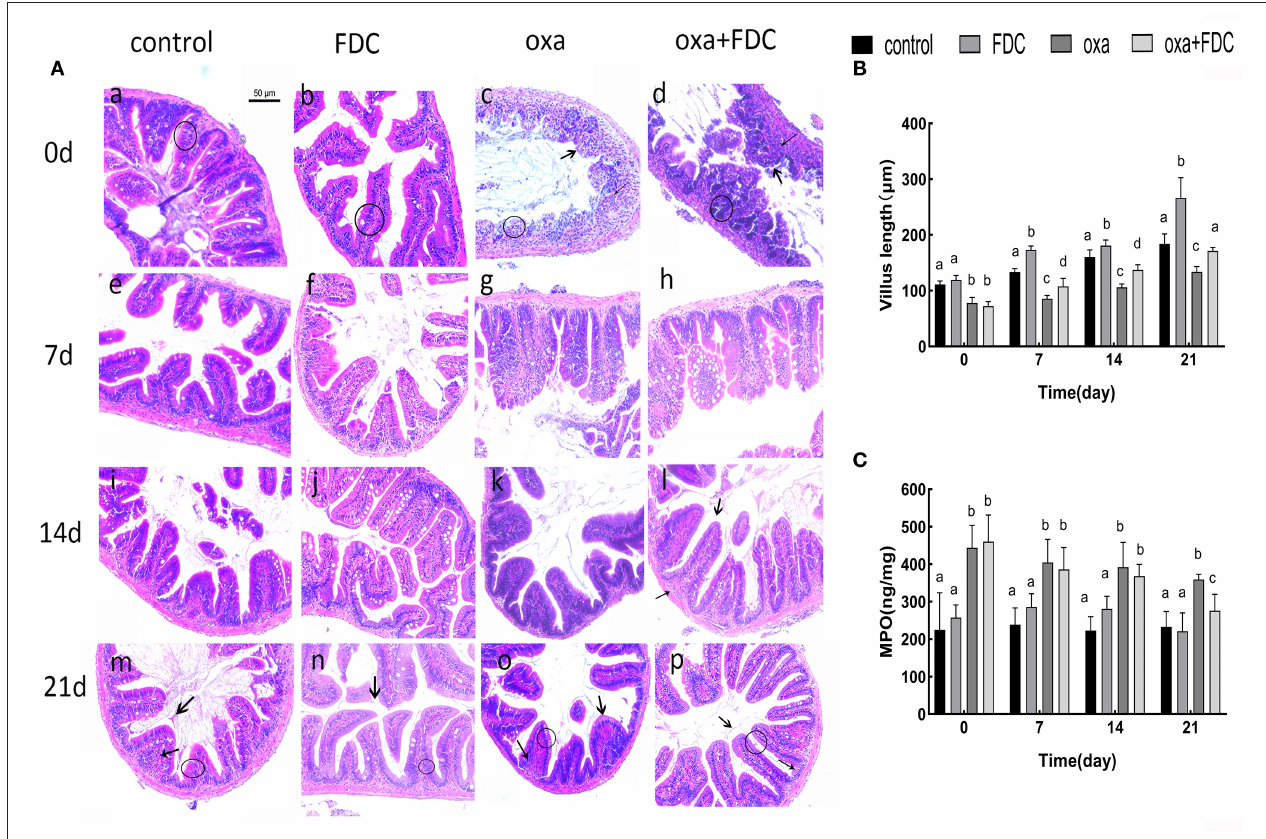
FIGURE 1 | (A) Histological examination of intestines stained with H&E. Bars = 50 µ m. “ ” indicates the intestinal villi, “ ” indicates to inflammatory cells, and “ ◦ ” stands for columnar epithelial cells. (B) The mucosal thickness of intestinal segments. (C) Neutrophil symbol: MPO. Data are expressed as the mean ± SD. The same letter is not significantly different from each other ( P < 0.05) on the same